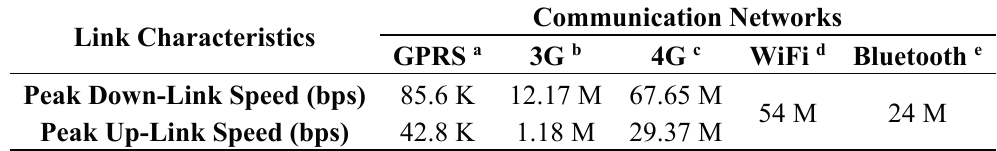
Table 6. Typical communication standards for interconnecting coordinator devices to remote back-end servers.